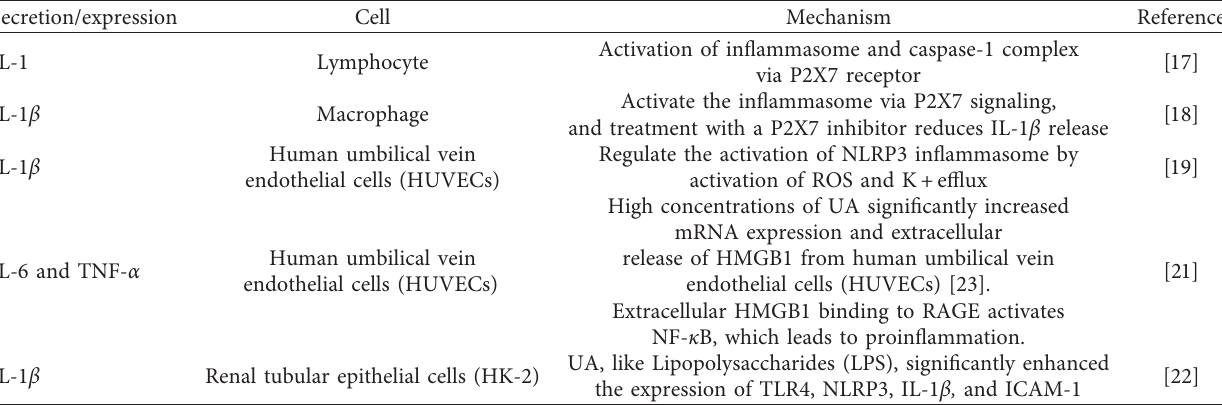
Table 1: Inflammatory mechanism of uric